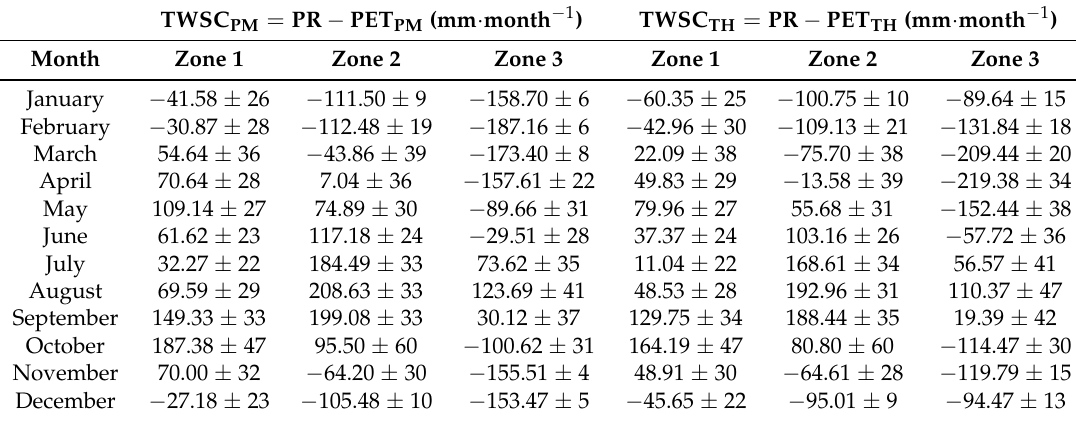
Table 3. Total water storage change (TWSC) from PET calculated using the Thornthwaite and Penman–Monteith formulas. Positive and negative values indicate the availability and deficit of rainwater in the area, respectively. Standard deviations are added to each value.